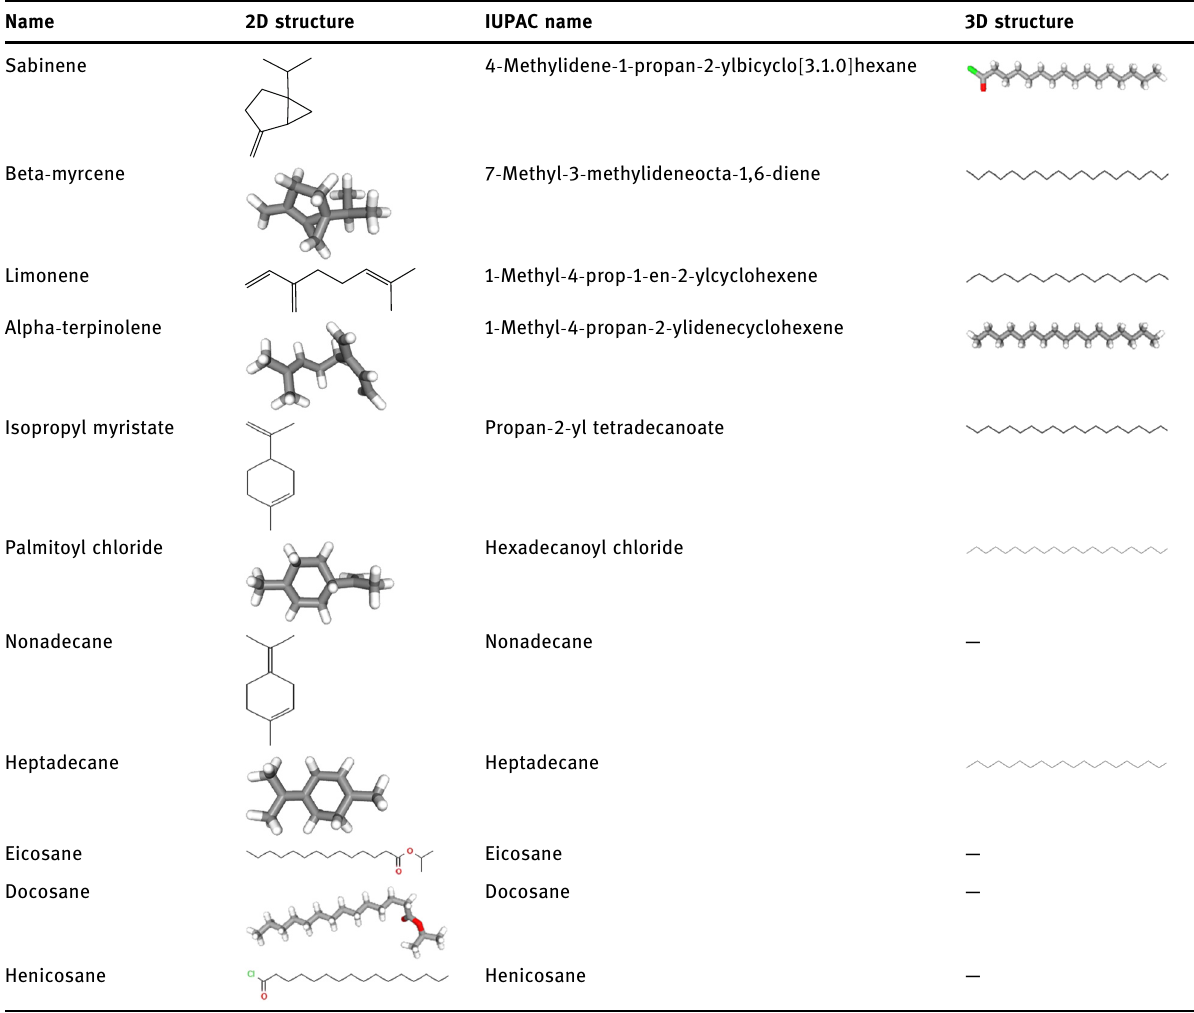
Table 2: Structural properties of identi fi ed compounds from C. sinensis Name